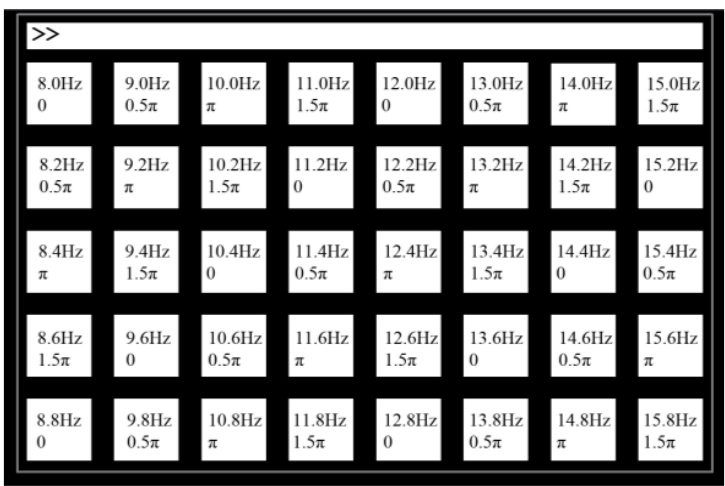
Figure 3. The computer screen for the stimulus presentation in the experiments of the benchmark